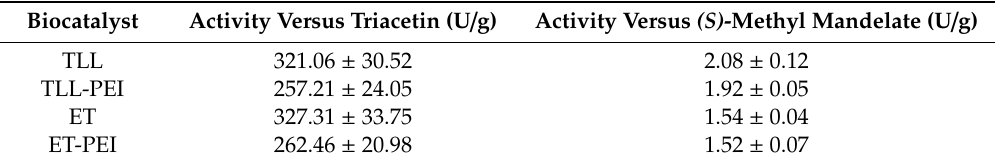
Table 2. Octadecyl lipase biocatalysts activities in hydrolysis of several esters. Other specifications are described in the Methods section.